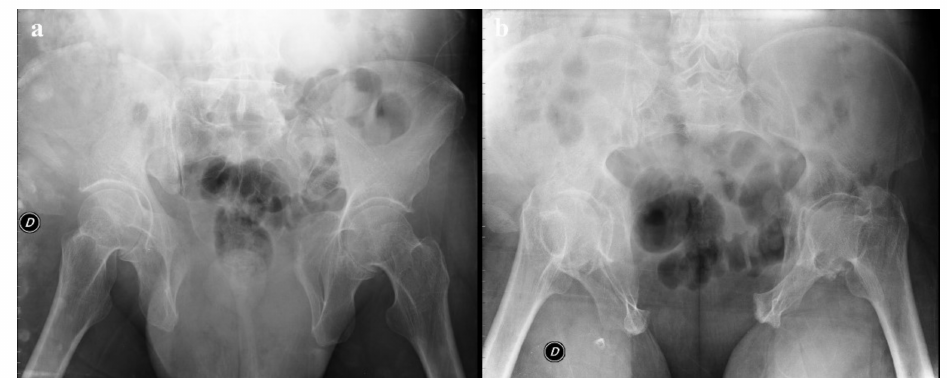
Figure 9. Plain radiography. The outlet view ( a ) and the inlet view ( b ) show a 5.2 cm diastasis of the pubic symphysis and anterior widening of the left-side sacroiliac joint. These findings have to be quickly reported to allow prompt